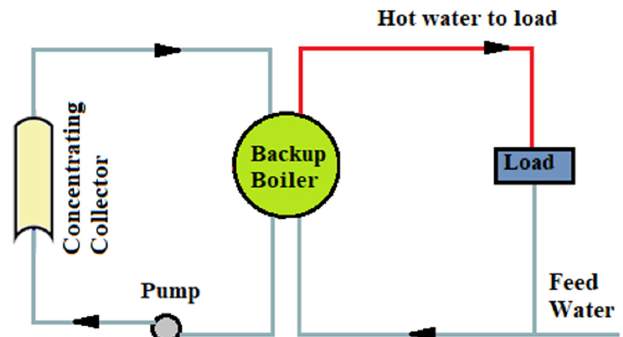
Figure 5. Indirect steam generation system with unfired boiler without backup. Adapted from Ref. [3], Copyright (2017), with permission from Elsevier.